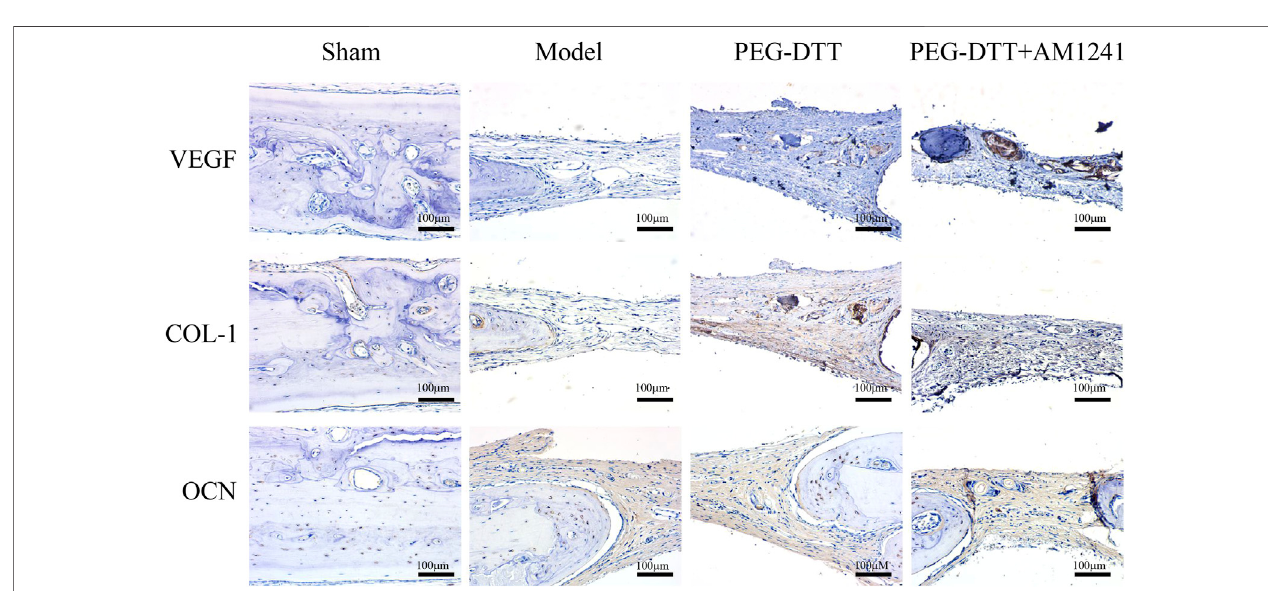
FIGURE 6 | Immunohistochemistry staining of VEGF, COL-1 and OCN among the four groups, scale bar = 100 μ m.